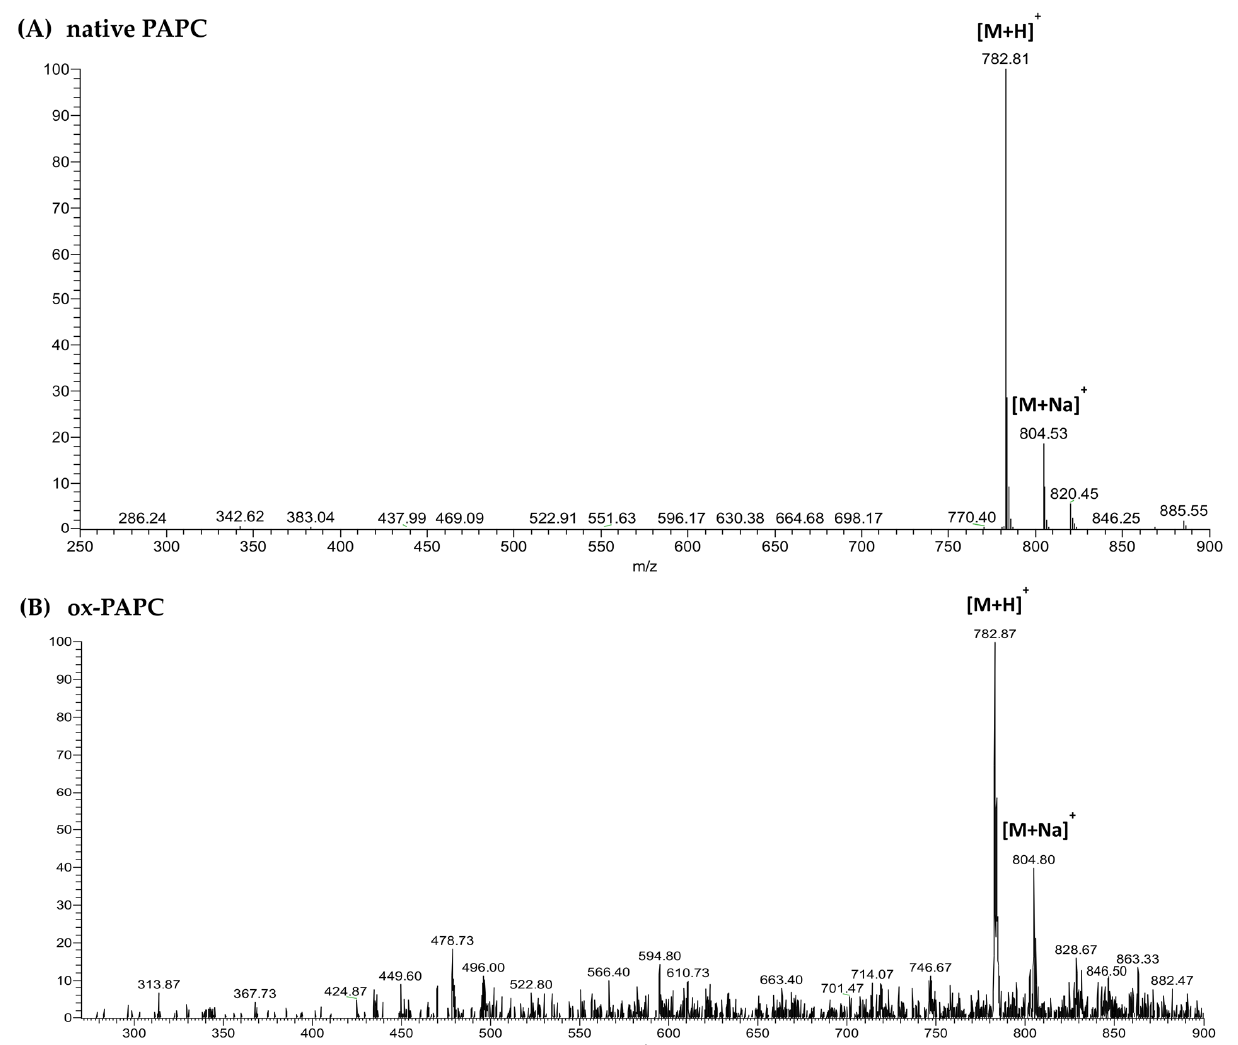
Figure 4. The ESI-MS spectra of ( A ) native PAPC and ( B ) ox-PAPC. Native PAPC standard was prepared at a concentration of 100 µg/mL. Ox-PAPC was obtained by in vitro oxidation (FeCl 2 :H 2 O 2 = 2:1) of native PAPC standard at 37 ◦ C for 15 min. The conditions used for ESI-MS analysis were sheath gas pressure, 10 psi; capillary temperature, 270 ◦ C; and injection time, 1000